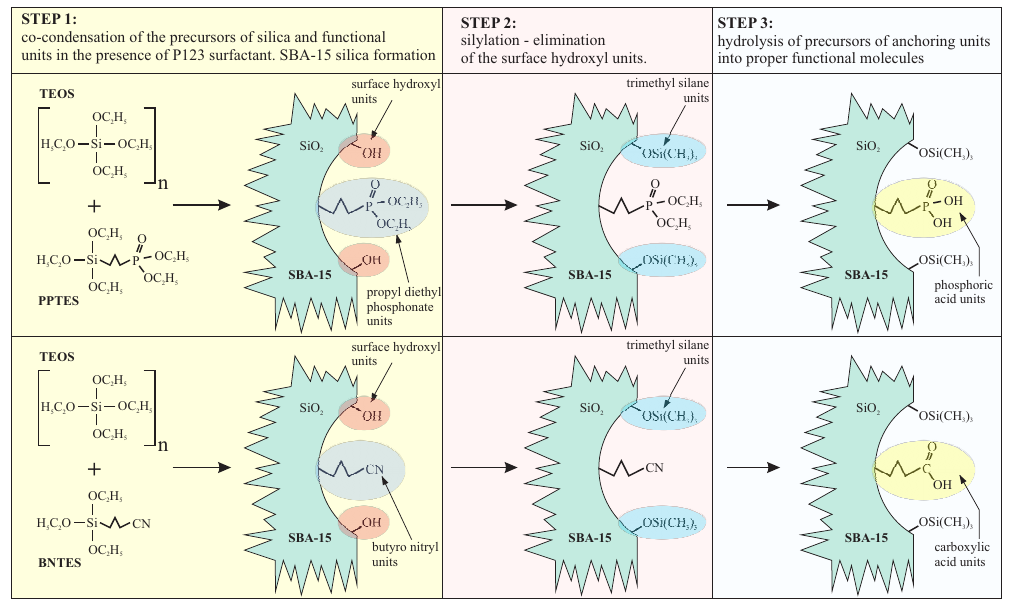
Figure 22. A diagram of the routes of the syntheses of the SBA-15 silica containing anchoring units: a propyl phosphoric acid (upper route) and a propyl carboxylic acid (bottom route). The number n denotes molls the number of tetraethyl orthosilicate (TEOS) per single moll of the precursor of functional units (phosphonate propyl diethyltriethoxysilane – PPTES or butyronitriletriethoxysilane—BNTES depending on the desired